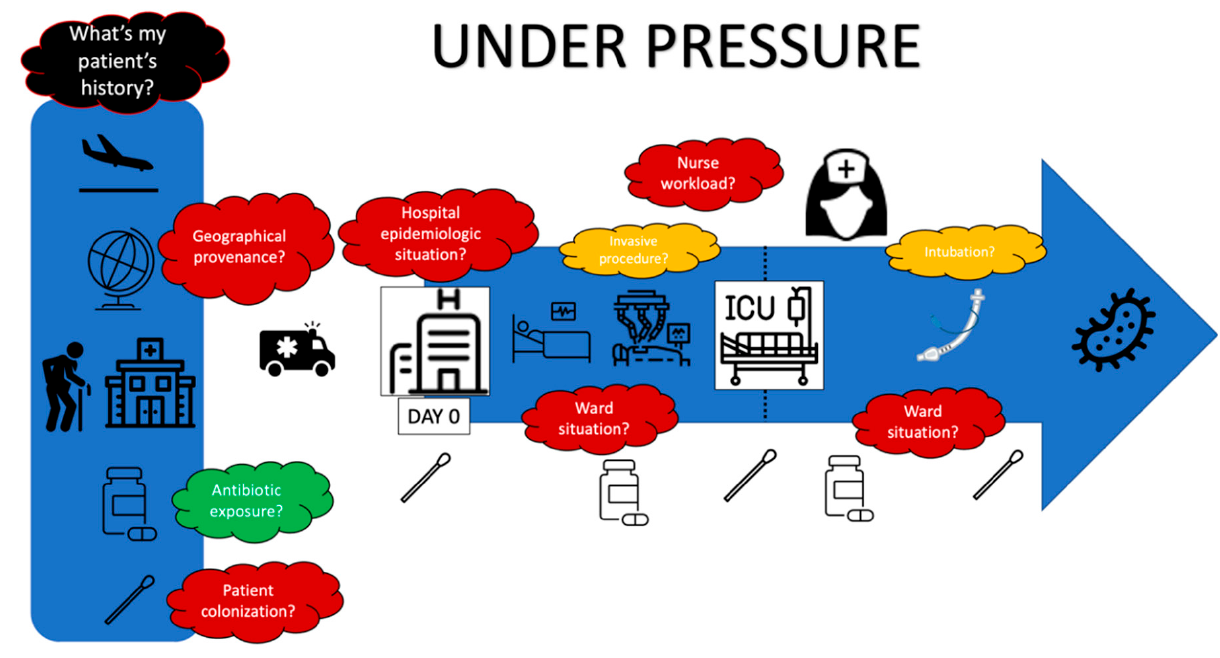
Figure 3. Under pressure.